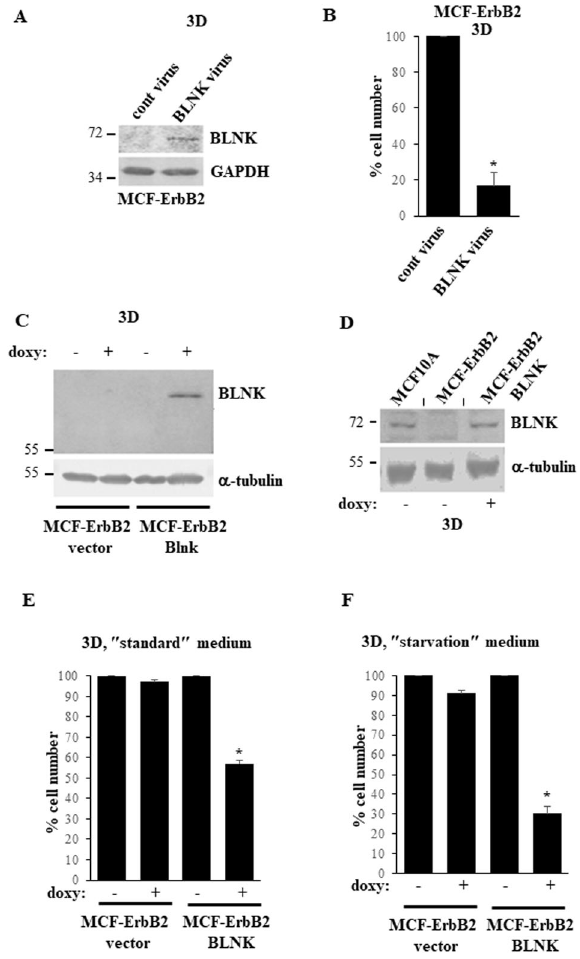
Fig. 4 Downregulation of BLNK is required for ErbB2-induced 3D growth of breast cancer cells. A MCF-ErbB2 cells infected with the control (cont virus) or the BLNK-encoding MMLV (BLNK virus) were cultured detached from the ECM for 24 h (3D) and assayed for BLNK levels by western blotting. GAPDH was used as a loading control. B MCF-ErbB2 cells treated as in A were detached from the ECM for 72 h (3D) and counted. The number of cells detected in the control sample was designated as 100%. C Indicated cell lines were cultured detached from the ECM (3D) for 48 h in the absence ( − ) or in the presence ( + ) of 5 ng/ml doxycycline (doxy) and assayed for BLNK expression by western blotting. α -tubulin was used as a loading control. D Indicated cell lines were cultured detached from the ECM (3D) for 6 h in the absence ( − ) or in the presence ( + ) of 5 ng/ml doxycycline (doxy) and assayed as in C . A short vertical black line was used to indicate that lanes were removed from the image and separate parts of an image were joined together. E Indicated cell lines were cultured for 72 h as in C in the ″ standard ″ medium (Hybri- Care medium supplemented with 10% Fetal Bovine Serum) used for culturing these cells in all experiments except for F and counted. The number of cells detected in the control sample was designated as 100%. F Cells cultured in the ″ starvation ″ medium which represented the Hybri-Care medium medium supplemented with 0.1% Fetal Bovine Serum and diluted 2.5-fold with HBSS medium were assayed as in E . The data in B , E , F are the average of the three independent experiments plus the SD. * p -value <